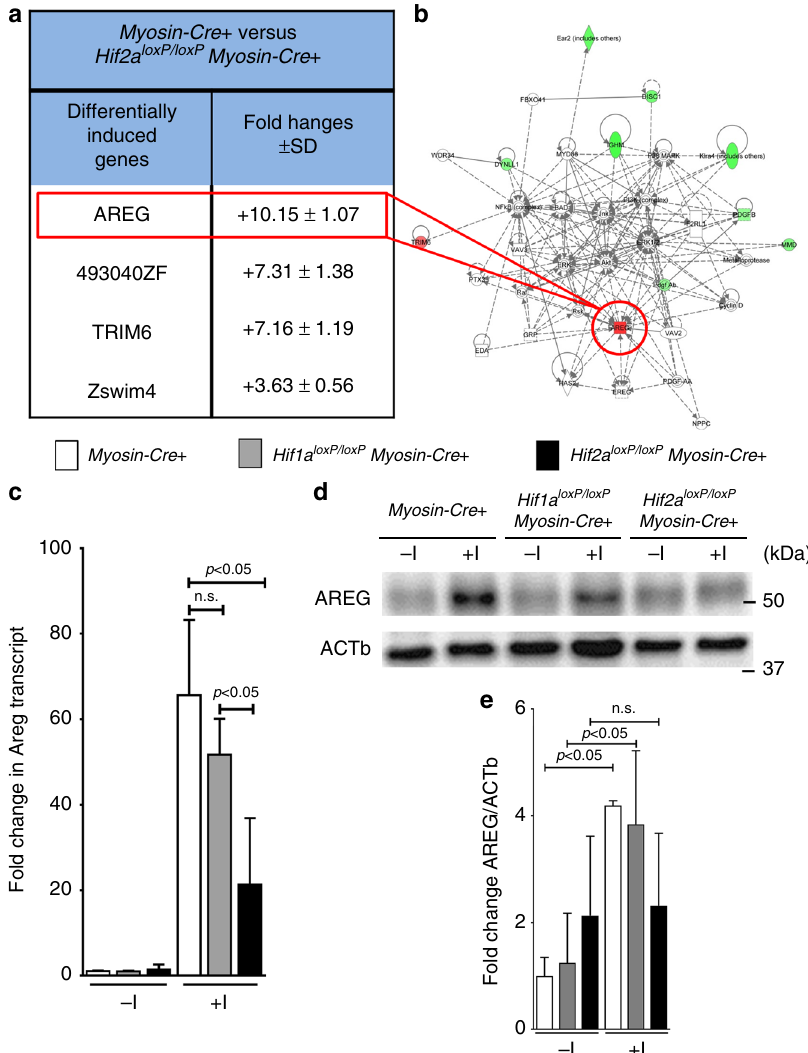
Fig. 2 Hif2a-dependent induction of amphiregulin during myocardial injury. a , b Myosin-Cre + or Hif2a loxP/loxP Myosin-Cre + underwent 45 min myocardial ischemia, followed by 120 min reperfusion. After harvest of the area-at-risk, total RNA was probed for transcriptional changes using a microarray technique (Agilent-014868 Whole Mouse Genome Microarray 4x44K G4122F Probe Name version). Transcriptional changes were calculated in relation to the myocardial baseline expression in untreated littermate controls of the same genotype. Array data have been deposited at http://www.ncbi.nlm.nih.gov/ geo/ (accession number GSE67308). a List of “ top hits ” of genes transcriptionally induced in the Area-At-Risk in Myosin-Cre + but unchanged in Hif2a loxP/ loxP Myosin-Cre + ( n = 4 per group, mean ± SD). Note: the most prominent differential regulation was found for the epidermal growth factor amphiregulin (Areg). b Analysis of relevant networks in the IPA ( Ingenuity Pathway Analysis ® ) library most signi fi cant to the dataset. Note: selective induction of Areg c Myosin-Cre +, Hif1a loxP/loxP Myosin-Cre +, or Hif2a loxP/loxP Myosin-Cre + underwent 60 min myocardial ischemia, following 120 min reperfusion. Total RNA from the area-at-risk was probed for transcriptional changes of Areg by real-time RT-PCR. Transcriptional changes were calculated relative to an internal housekeeping gene ( Actb ). Data are expressed as mean fold change ± SD compared to untreated myocardial tissue from littermates of the respective genotype compared by one-way ANOVA followed by Bonferroni ’ s multiple comparison test ( Myosin-Cre +: − I n = 6, +I n = 5; Hif1a loxP/loxP Myosin-Cre +: − I n = 3; +I n = 4; Hif2a loxP/loxP Myosin-Cre +: − I n = 6; +I n = 7; F 5,25 = 33.53; p < 0.0001). d AREG immunoblot performed for protein isolated from the ischemic myocardial tissue after 60 min of ischemia and 120 min reperfusion or untreated littermate controls of Myosin-Cre + , Hif1a loxP/loxP Myosin-Cre + or Hif2a loxP/loxP Myosin-Cre +, respectively. A representative image of three individual experiments is presented. e Quanti fi cation by densitometry of the AREG immunoblot results relative to ACTb. Data are expressed as mean fold change ± SD normalized to untreated myocardial tissue from Myosin-Cre + compared by one-way ANOVA followed by Bonferroni ’ s multiple comparison test ( n = 3 per group; F 5,12 = 4.487; p =